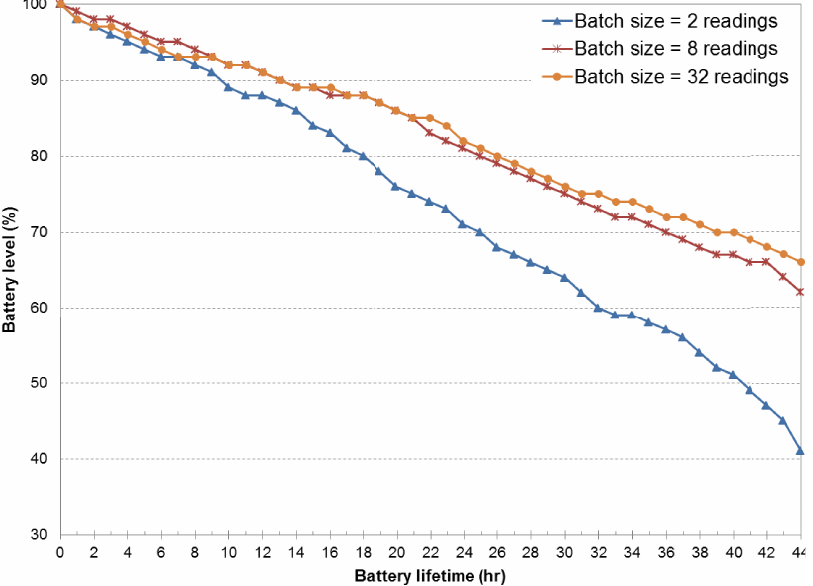
Figure 5. Battery lifetime of region-based sensing policy with three batch transmission schemes and variable readings.